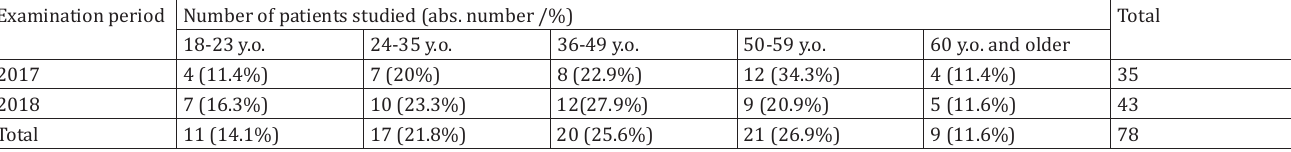
Indicator of age characteristics of patients with urolithiasis who underwent ultrasound